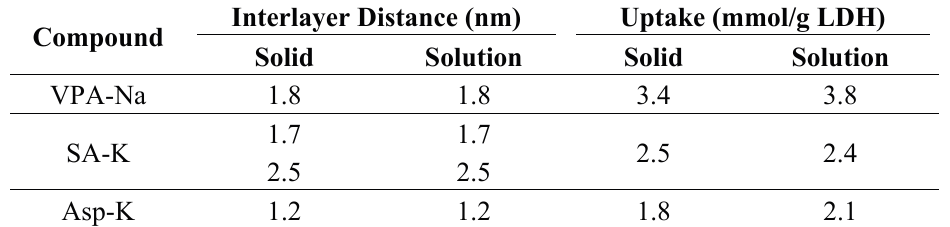
Table 2. Interlayer distance ( d ) and uptake of sodium valproate (VPA)-Na, SA-K,